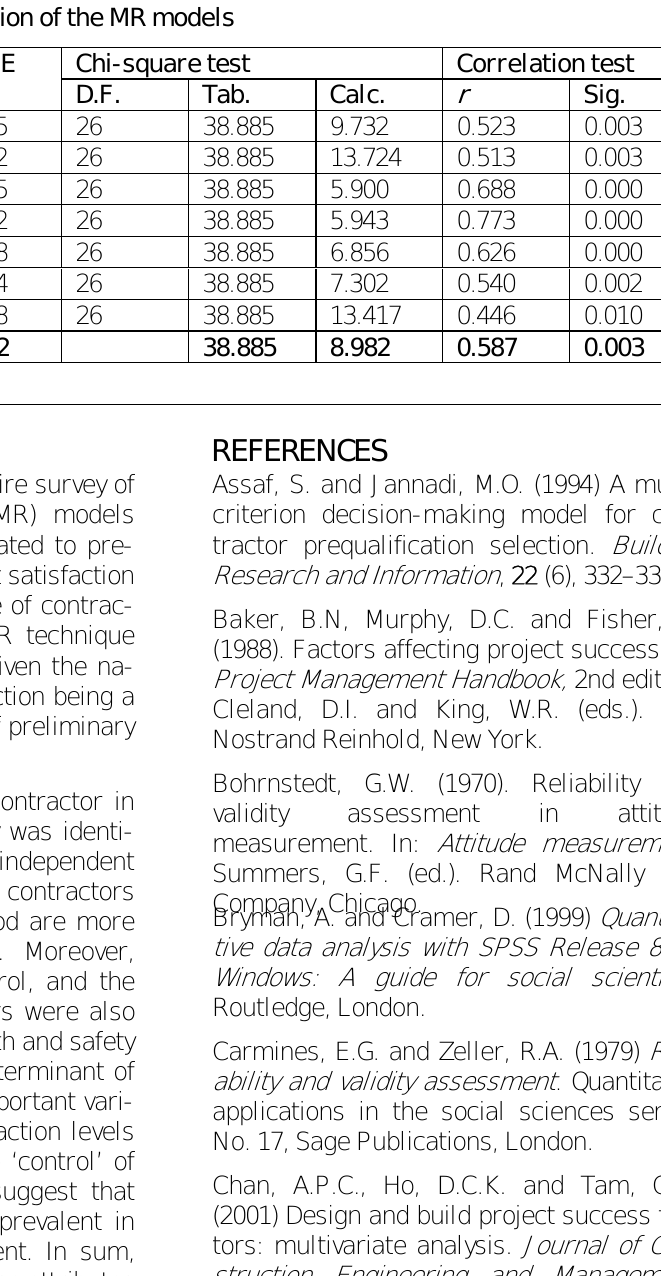
Table 6: Summary of the validation of the MR models